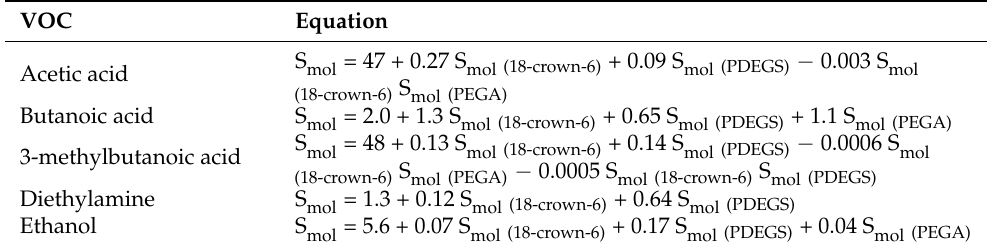
Table 7. Regression equations for predicting the molar-specific sensitivity (S mol ) of microbalance